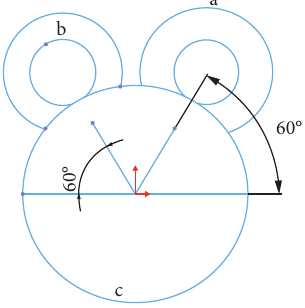
Figure 3: Gear installation position